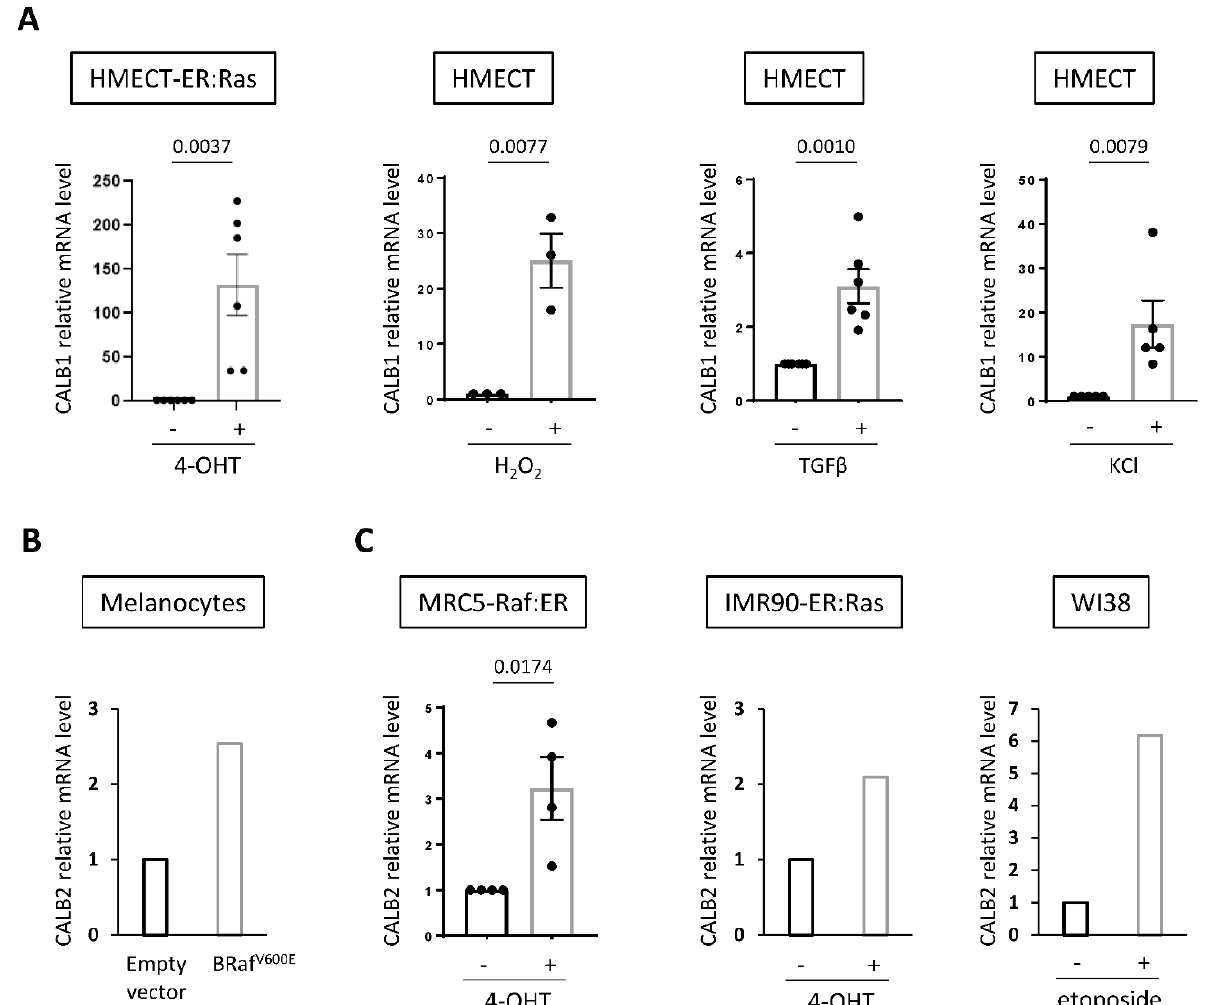
Figure 5. Expression of calbindins is induced in many senescence contexts. ( A ) Additional contexts where CALB1 expression is upregulated in HMECT in response to senescence inducers. CALB1 mRNA level was measured by RT-qPCR in HMECT overexpressing 4-OHT-inducible ER:Ras onco- gene (day 6 after 100 nM 4-OHT treatment, n = 6) or treated with H 2 O 2 (at 250 µM for 1 h and RNA were collected six days later, n = 3), TGF β (at 0.5 ng/mL for three days, n = 6) or KCl (at 65 mM for 24 h, n = 5). ( B , C ) CALB2 expression is increased in several senescence contexts. ( B ) CALB2 mRNA level measured in melanocytes overexpressing B-RAF V600E oncogene (transcriptome data [22]). ( C ) CALB2 mRNA level measured in normal human embryonic lung fibroblasts MRC5 overexpressing 4-OHT-inducible Raf:ER oncogene (RT-qPCR at day 3 after 100 nM 4-OHT treatment, n = 4), IMR90 overexpressing 4-OHT-inducible ER:Ras oncogene (transcriptome data [23]) or WI38 treated with etoposide (transcriptome data [24]). For RT-qPCR, mean +/ − SEM of independent experiments are shown. Unpaired t -test (for HMECT-ER:Ras, HMEC H 2 O 2 , HMEC TGF β , and MRC5-Raf:ER) or Mann–Whitney test (for HMECT KCl) were performed and p -values are indicated.